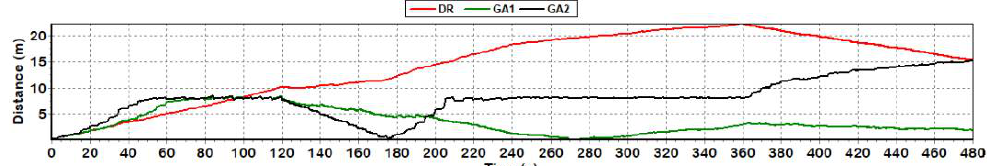
Figure 3. Reference and DR, GA1, GA2 estimated paths of vehicle F obtained in the course of con- ducting: ( a ) A single test sample; ( b ) A hundred test samples.